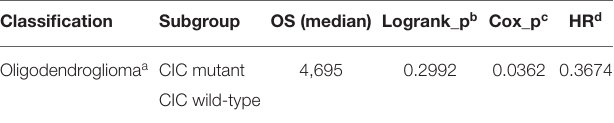
TABLE 3 | Associations between CIC mutation and OS of patients with Oligodendroglioma.